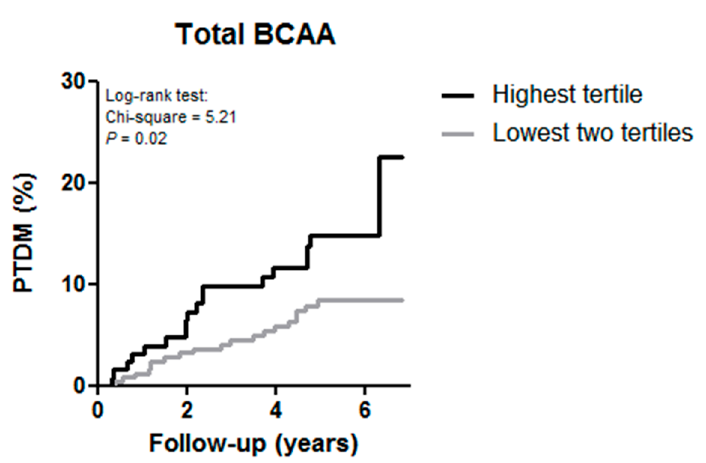
Figure 1. Kaplan–Meier curves for the development of post-transplant diabetes mellitus (PTDM) according to the highest tertile versus the two lowest tertile of total branched chain amino acids (BCAA) in renal transplant recipients.